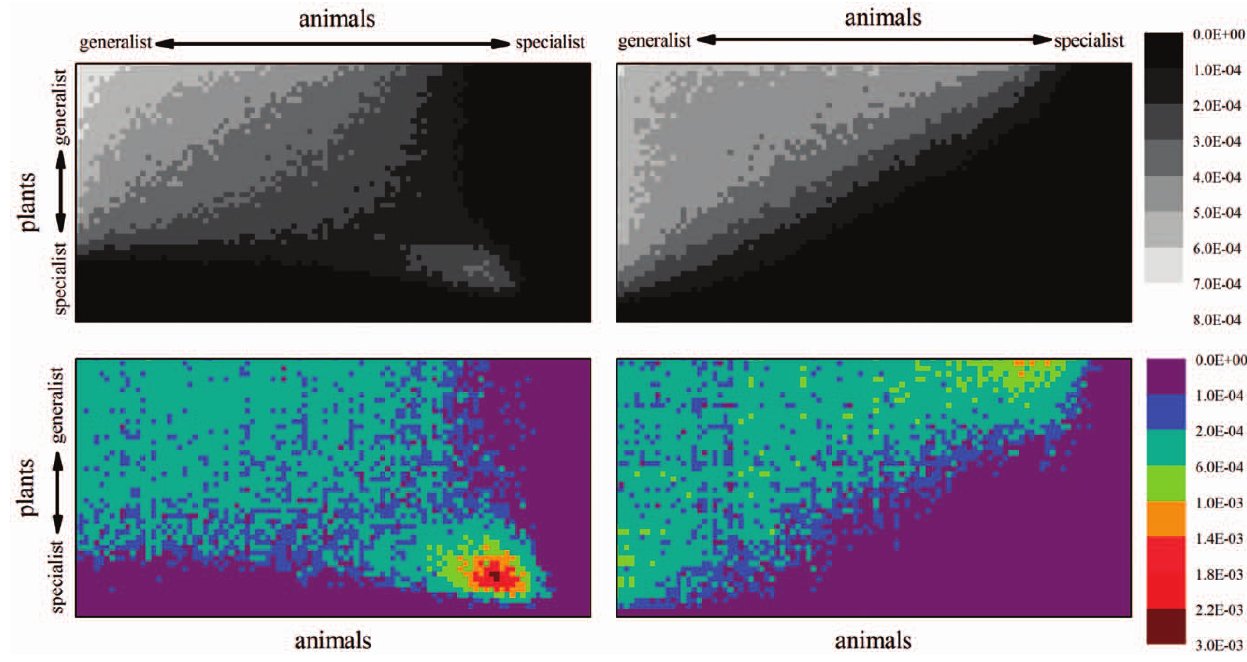
Figure 10. Removed links. Top: Probability density plots of existing links in assortative (left) and disassortative (right) models. Both cases correspond to 50 | 100 systems with a density of links r ~ 0 : 2 , and are obtained from 1000 random realizations of the systems within the rhomboid and the triangle models. The probability is normalized for the whole network. Bottom: Probability density of the extinction of links when the parameter of destruction is d ~ 0 : 5 , corresponding to the models on top. This probability is also normalized for the whole network. (The scales for the both plots of each row are shown on the right. Different shades are used to emphasize that the scales are different and that the represented magnitudes are different also.).